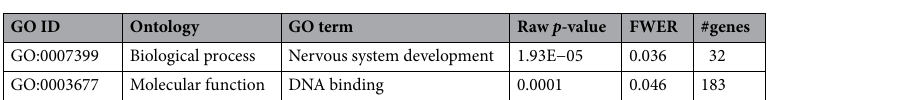
Table 1. Enriched overrepresented GO terms in DEGs of 15q13.3